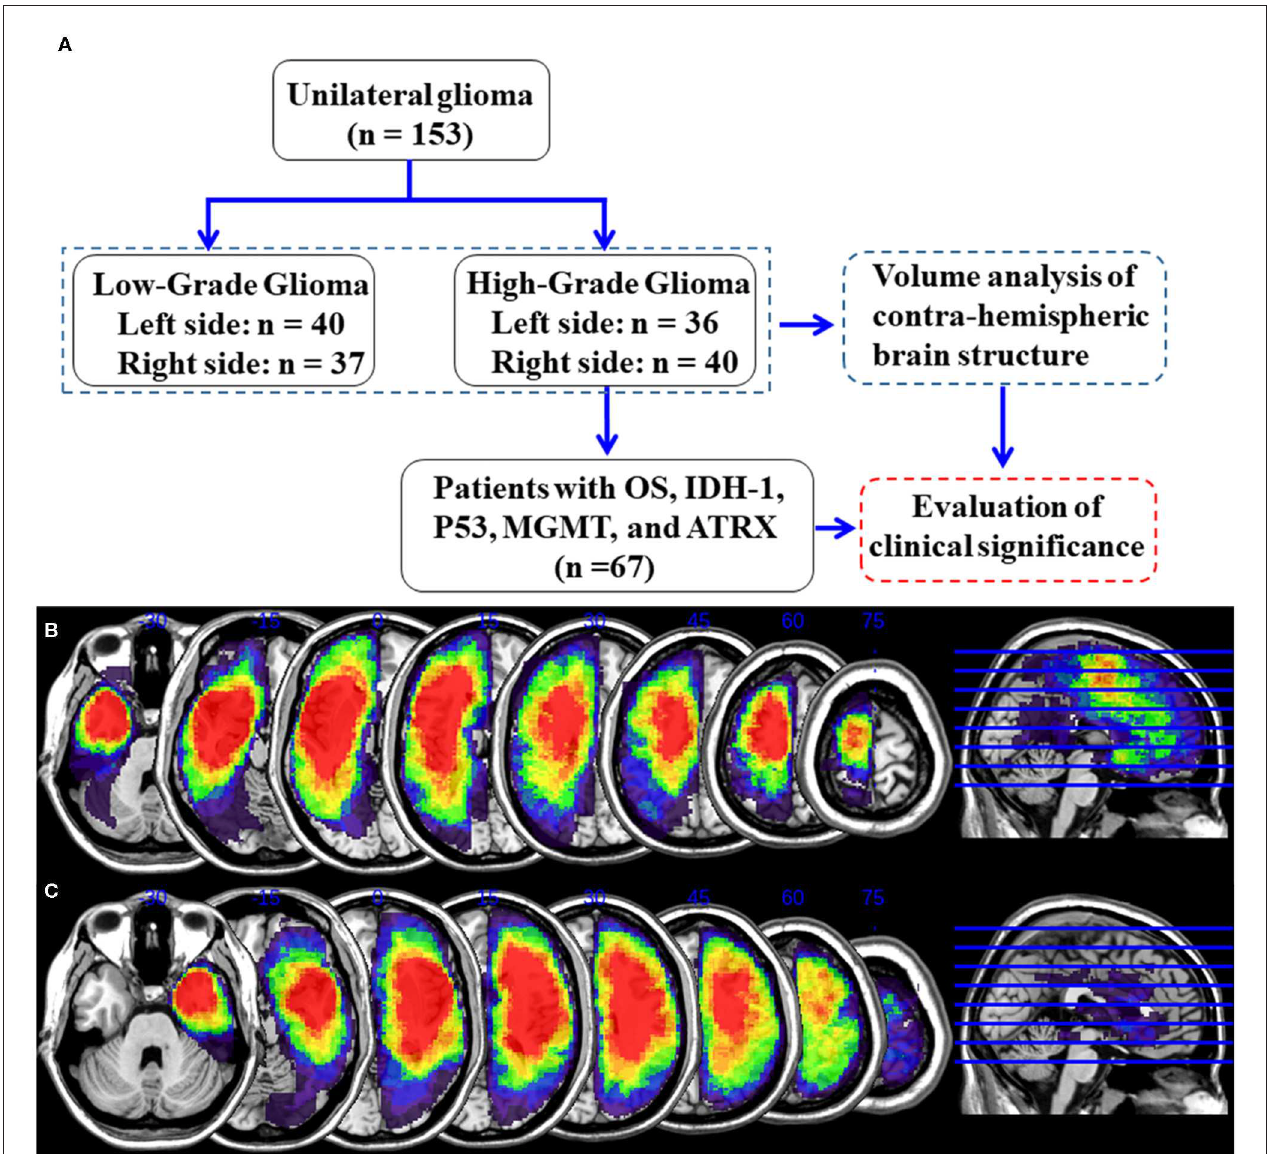
FIGURE 1 | Detailed flow chart of the analysis and glioma overlap map. (A) Flowchart of analysis. (B) Left hemisphere glioma overlap map. (C) Right hemisphere glioma overlap map.